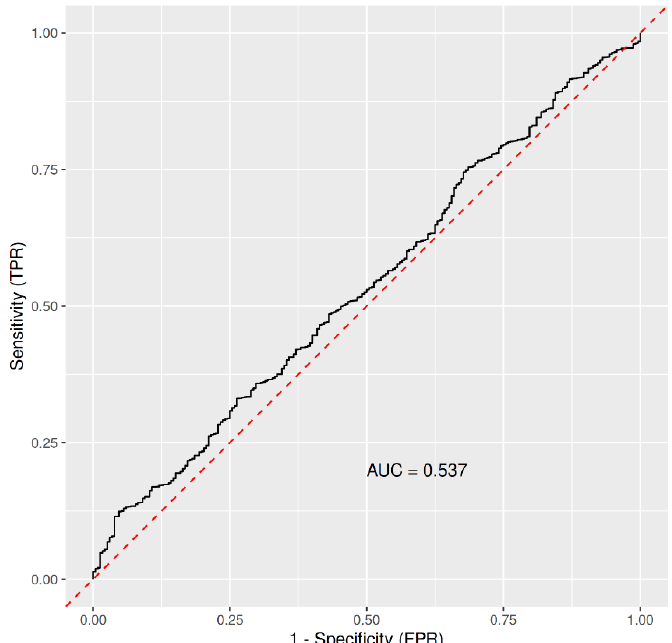
Figure 1. ROC based on the Out-Of-Bag data from imbalanced RandomForest, trained on 2111 con- trols (probands who were not infected with COVID-19) and 232 COVID-19 cases, with frequency of inflammation of upper respiratory tract, weight, height, age, gender, being a cold/ice water swimmer, being a sportsman, and frequency of cold/ice water swimming as predictors. Abbreviations: AUC, area under the curve; FPR, false positive rate; TPR, true positive rate.